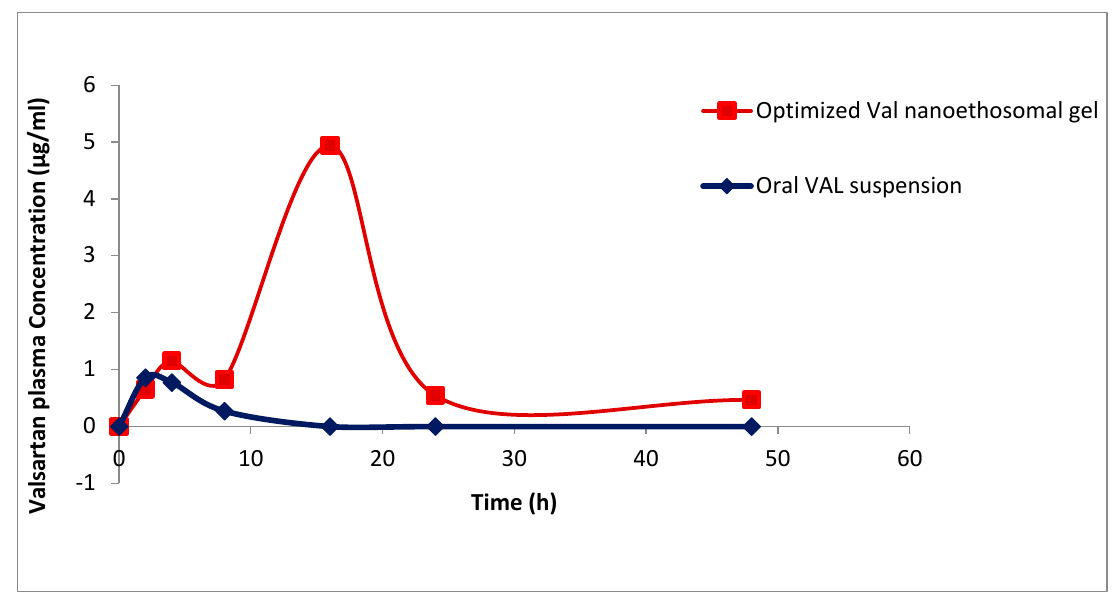
Figure 7. Plasma concentration time profiles of valsartan in rats after administration of oral suspension and optimized VAL nanoethosomal gel (mean ± SD).